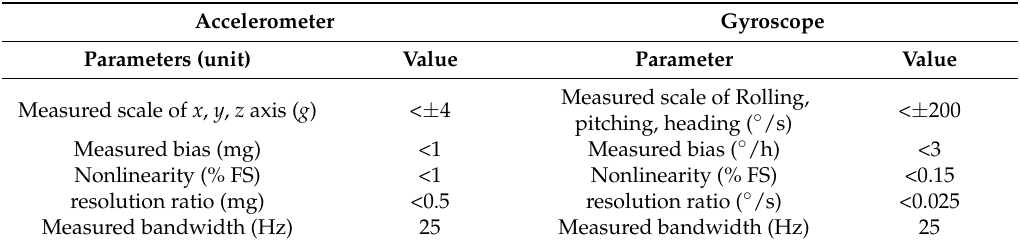
Table 1. The main parameters of the MEMS accelerometer and gyroscope.